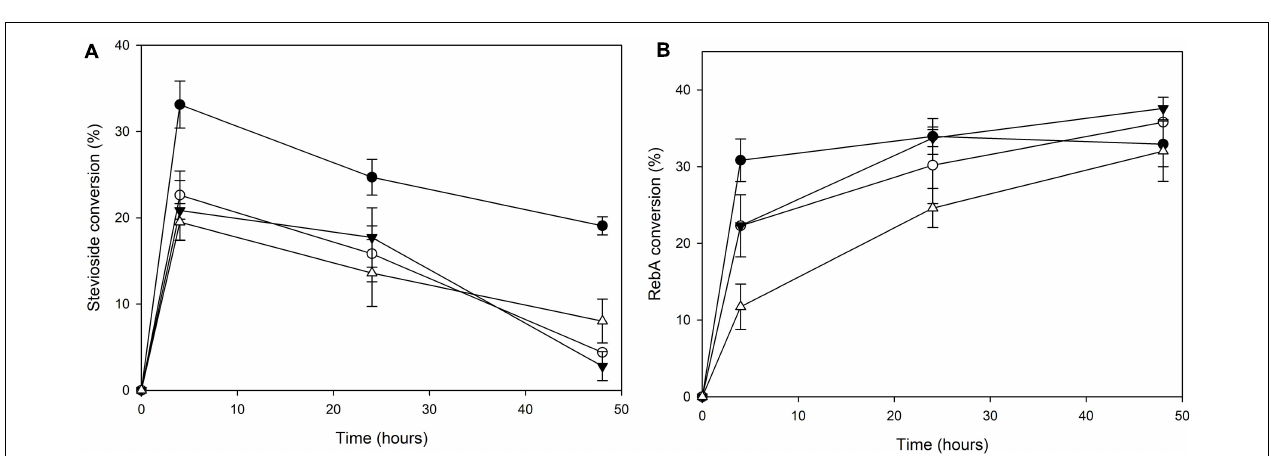
FIGURE 2 | Tt bGal1-mediated transglycosylation of steviol glycosides. EICs, MS and MS/MS spectra of the detected transglycosylated products provided by HILIC-HRMS using as acceptor (A) stevioside (B) RebA.